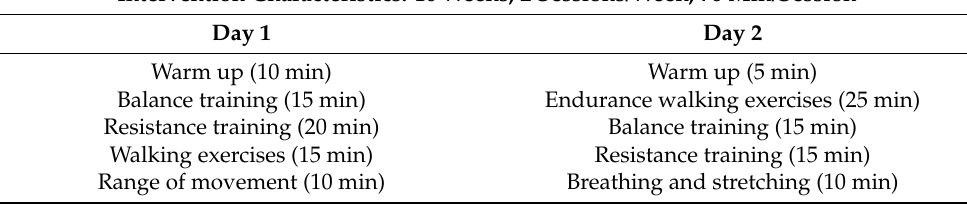
Table 1. Characteristics of the exercise program (day 1 and day